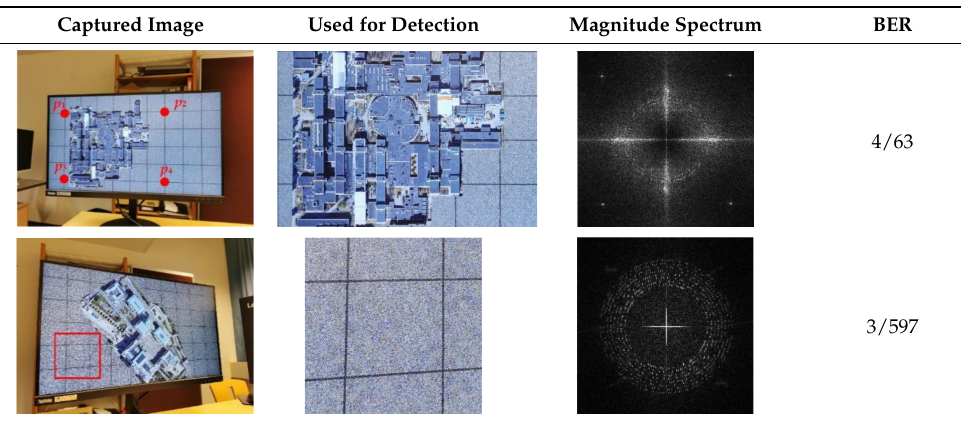
Table 12. Watermark extractions from partial decrypted